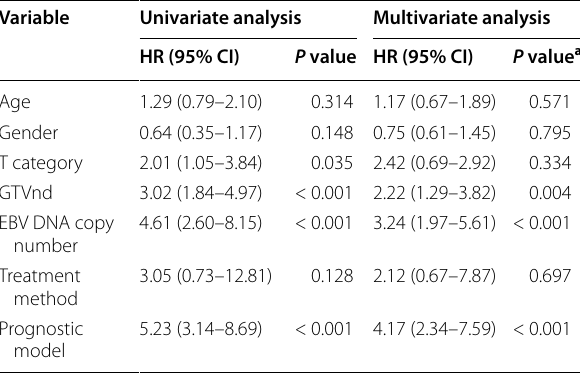
HR hazard ratio, CI confidence interval, GTVnd gross tumor volume of lymph nodes, EBV Epstein–Barr